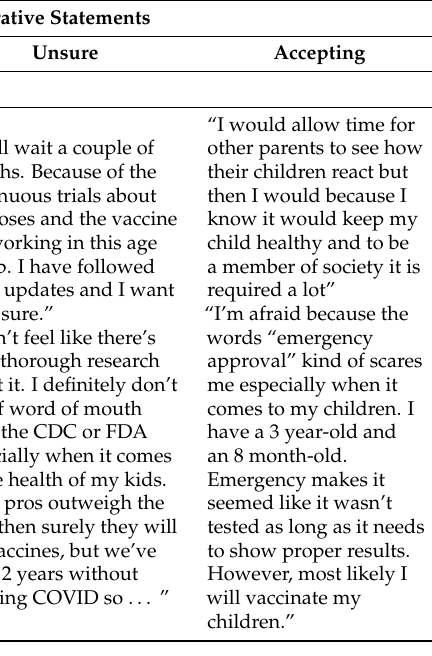
Table 4. Definition of thematic categories and illustrative statements across vaccine intent